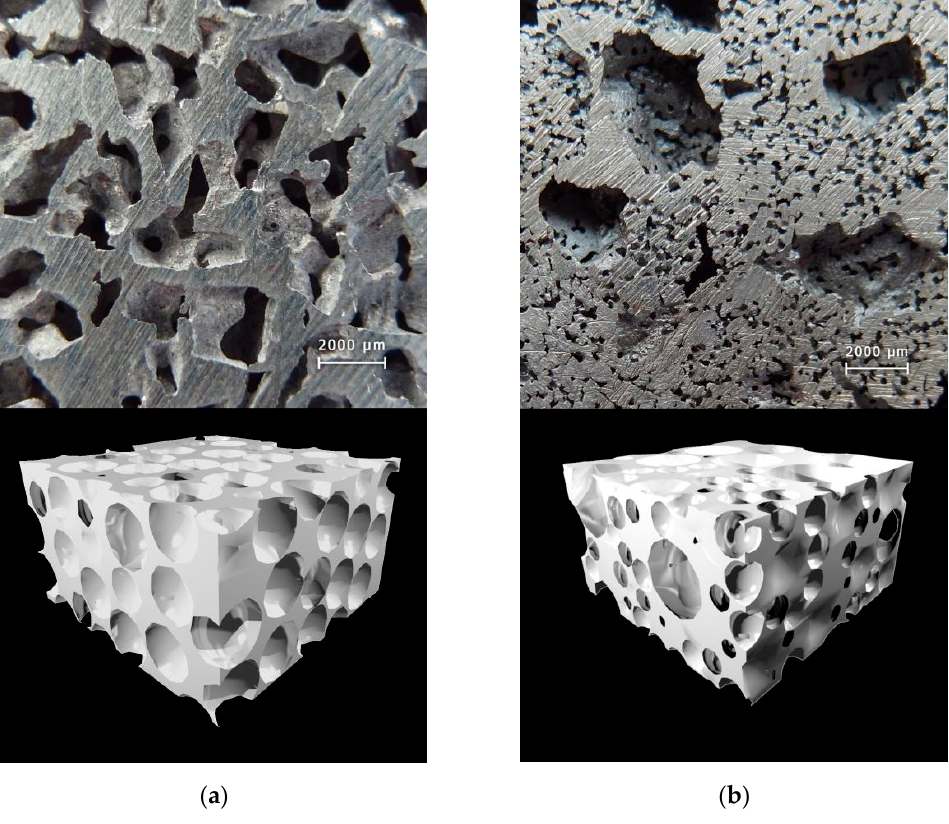
Figure 4. The macrostructure and corresponding 3D model of Al replicated foam produced using: ( a ) a monodispersed space holder and ( b ) a double-granular space holder.